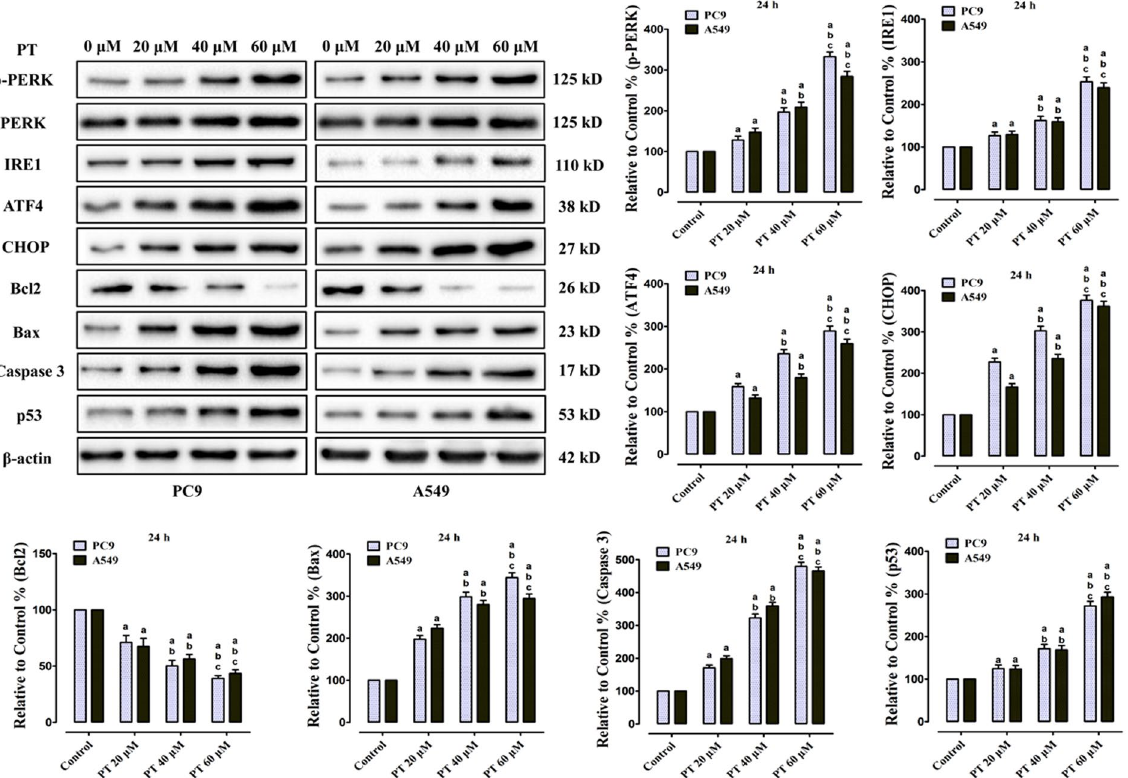
Figure 5. Effect of PT treatment on the ERS signaling and apoptosis-related proteins in PC9 and A549 cells (24 h). Representative western blot results of p-PERK, PERK, IRE1, ATF4, CHOP, Bcl2, Bax, Caspase 3, p53 were shown. Membranes were re-probed for β -actin expression to show that similar amounts of protein were loaded in each lane. All of the results were expressed as the mean ± SD; n = 6. a P < 0.05 vs . the control group, b P < 0.05 vs . the 20 μ M PT-treated group, c P < 0.05 vs . the 40 μ M PT-treated